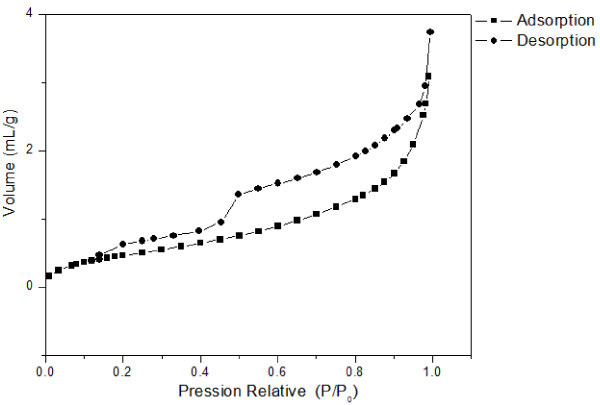
N2adsorption/desorption isotherm of the HTC-processed carbon membrane.